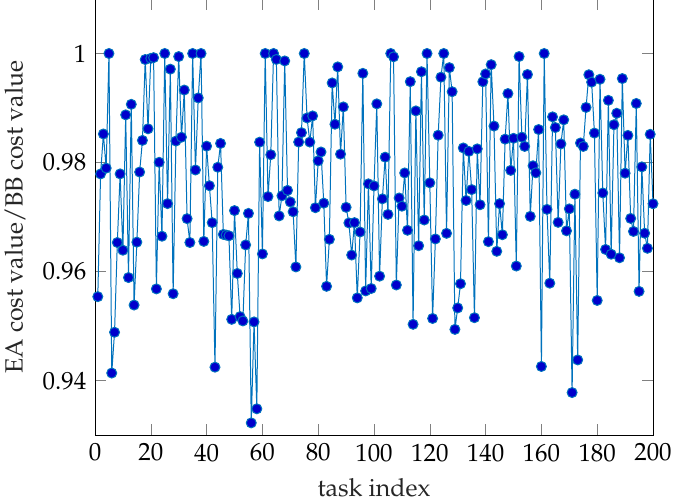
Figure 3. The accuracy rate of the Branch and Bound